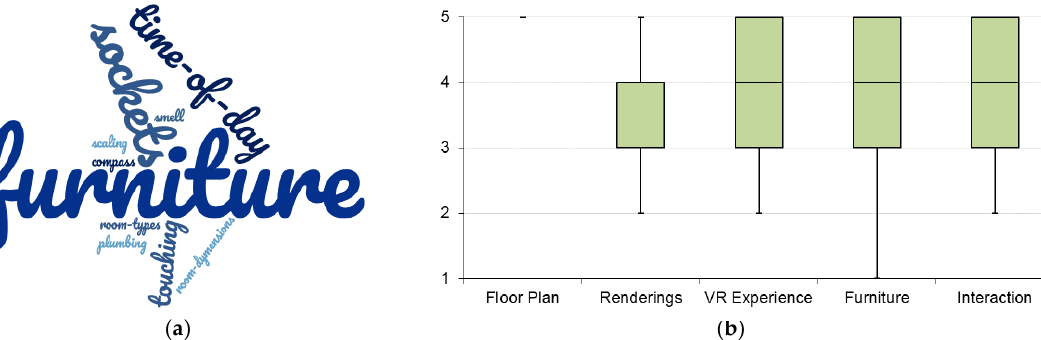
Figure 21. ( a ) Participants were missing these topics in the VR environment without furniture. The bigger the font size the more people asked for this special topic. ( b ) The importance of representations of a real estate. The floor plan was rated uniformly with the highest value.